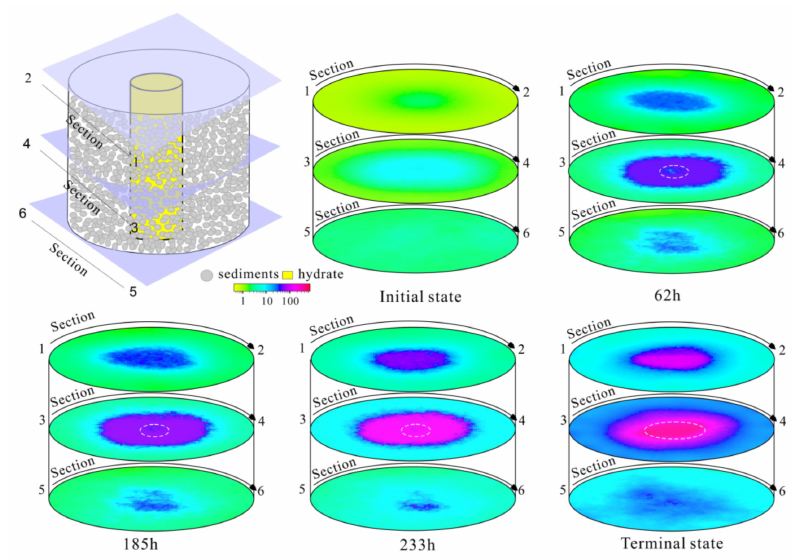
Figure 7. Resistivity change caused by the formation of hydrate in the horizontal profiles of